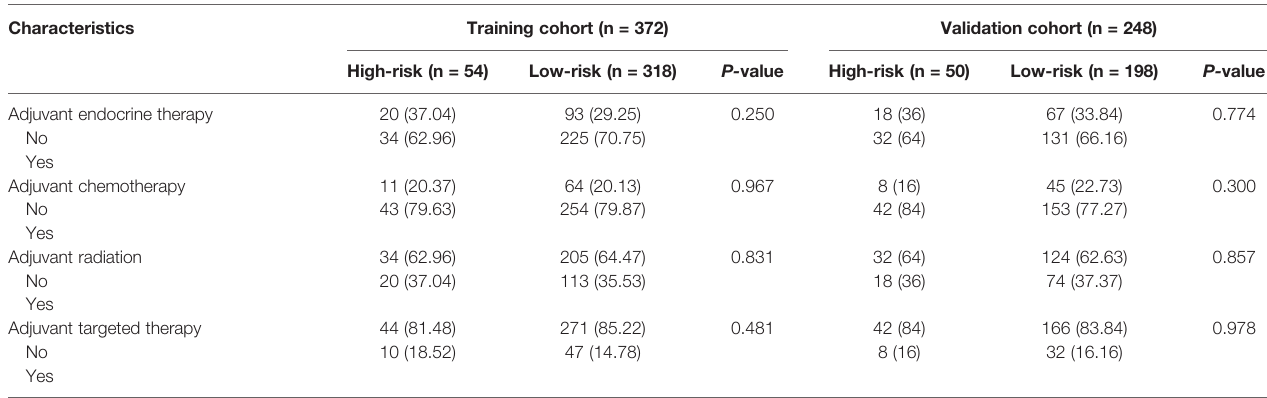
Frontiers in Oncology |